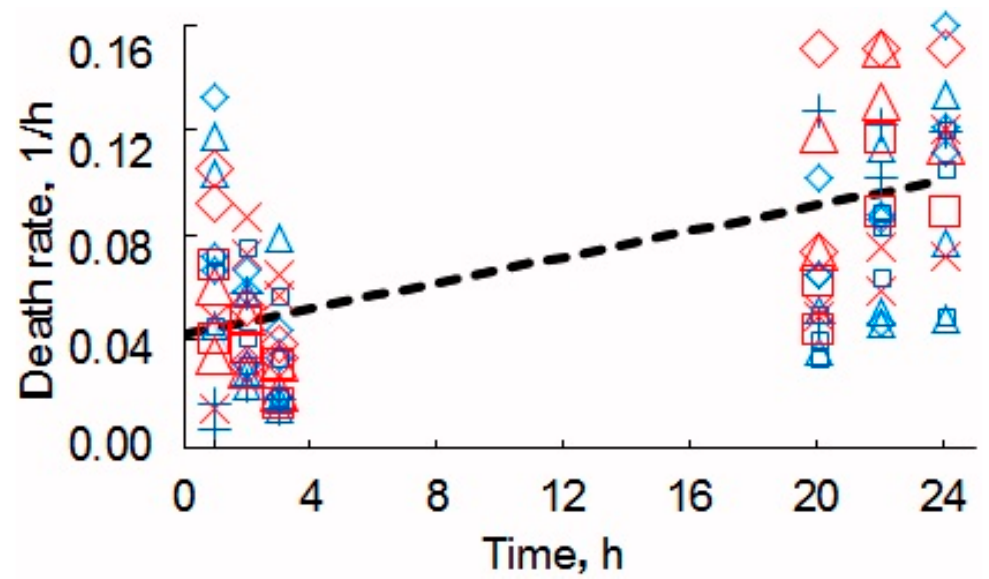
Figure 5. Relative death of the yeast cells. Blue symbols correspond to cell staining with methylene blue and monitoring by optical microscopy, the red, to PI and the fluorescence microscope. The number of cells without MW-CNTs x or + and with MW-CNTs squares, triangles, and rhombs.